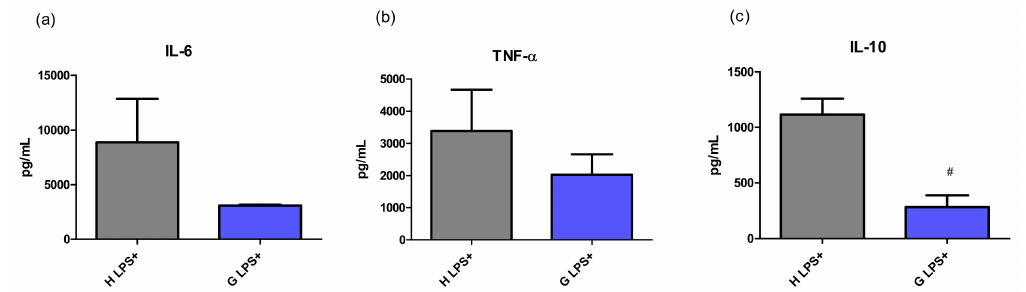
Figure 3. The e ff ect of LPS-induced inflammation on cytokine concentration in serum of hyperbilirubinemic Gunn rats. Concentrations of pro-inflammatory cytokines IL-6, TNF- α , and anti-inflammatory IL-10 were measured 12 h after LPS administration (6 mg / kg i.p.) in normobilirubinemic heterozygous controls (H LPS + ) and hyperbilirubinemic Gunn rats (G LPS + ), respectively. # p < 0.05 vs. LPS-treated group. n = 5 animals per group (minimum).